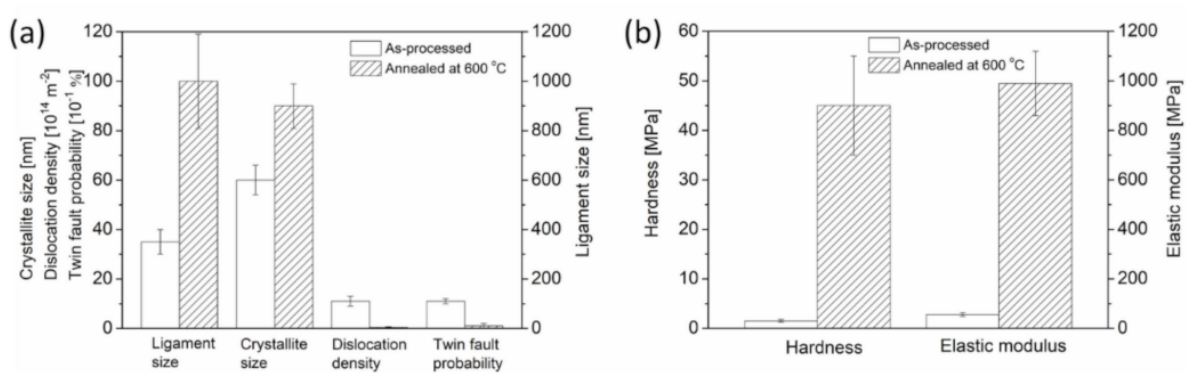
Figure 6. Comparison of ( a ) microstructural parameters and ( b ) hardness and elastic modulus obtained via indentation measurements for Cu foams processed by route C, as well as its counterpart material that was annealed at 600 ◦ C for 5.5 h after